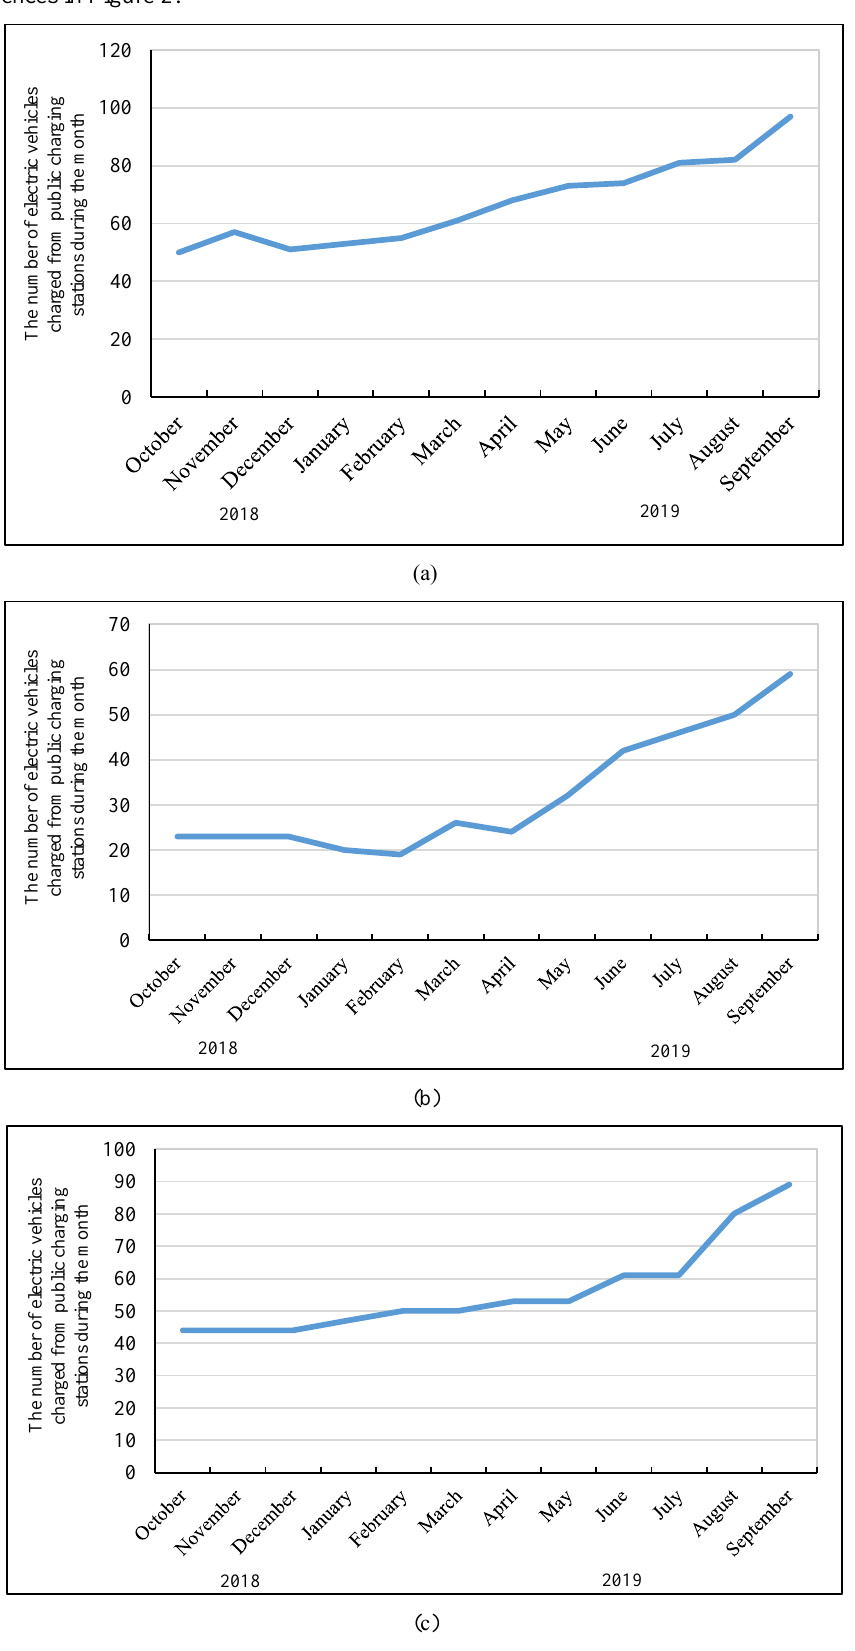
Figure 2. Curves of changes in the number of electric vehicles charged from public charging infrastructure in: (a) Krasnodar; (b) Yekaterinburg; (c)